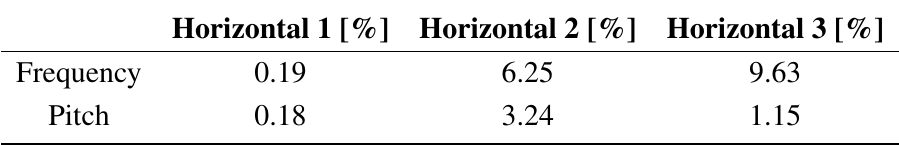
Table 2. Performance comparison of different step length